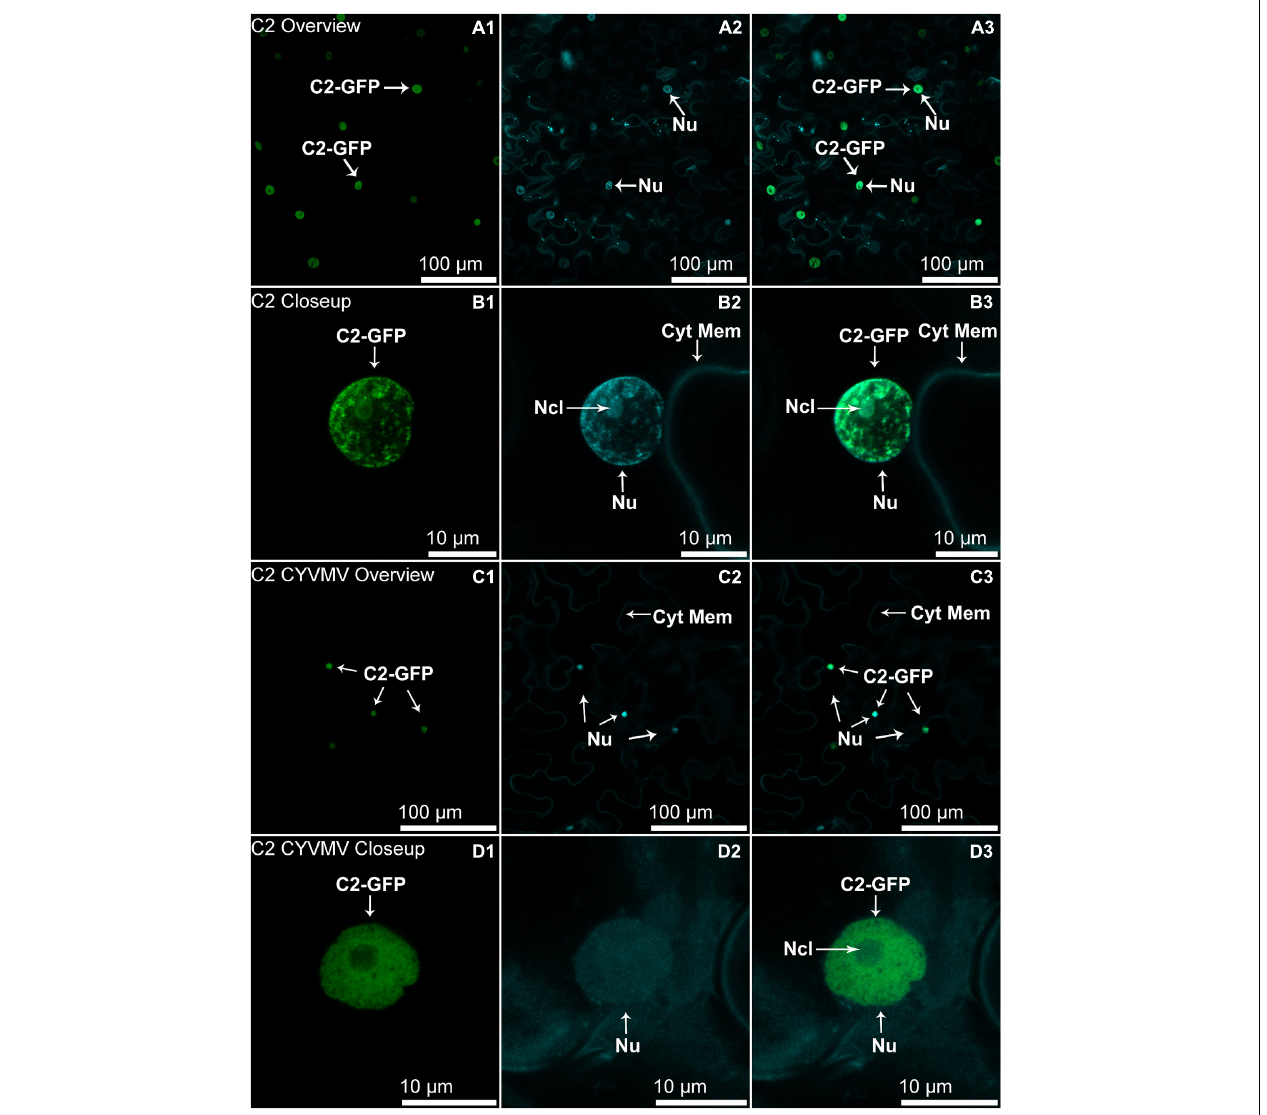
FIGURE 4 | Subcellular localizations of CYVMV, C2-GFP in N. benthamiana leaves under stand-alone (A,B) and CYVMV-inoculated (C,D) conditions. Panels (A,C) were taken under lower zoom, while panels (B,D) were taken with higher zoom. Images showing GFP fluorescence (A1,B1,C1,D1) , and Hoechst fluorescence (A2,B2,C2,D2) . Merged images of both GFP and Hoechst fluorescence were shown as panels (A3,B3, C3, D3) . C2-GFP alone diffused in the nucleus, with most of the proteins located in the nucleoplasm. The presence of CYVMV did not dramatically change the subcellular localization pattern of C2-GFP except that its accumulation in the nucleolus was almost abolished. Arrowheads indicate the locations of C2-GFP and major sub-cellular organelle (Nu, nucleus, Ncl, nucleolus, Cyt Mem, cytoplasmic membrane).